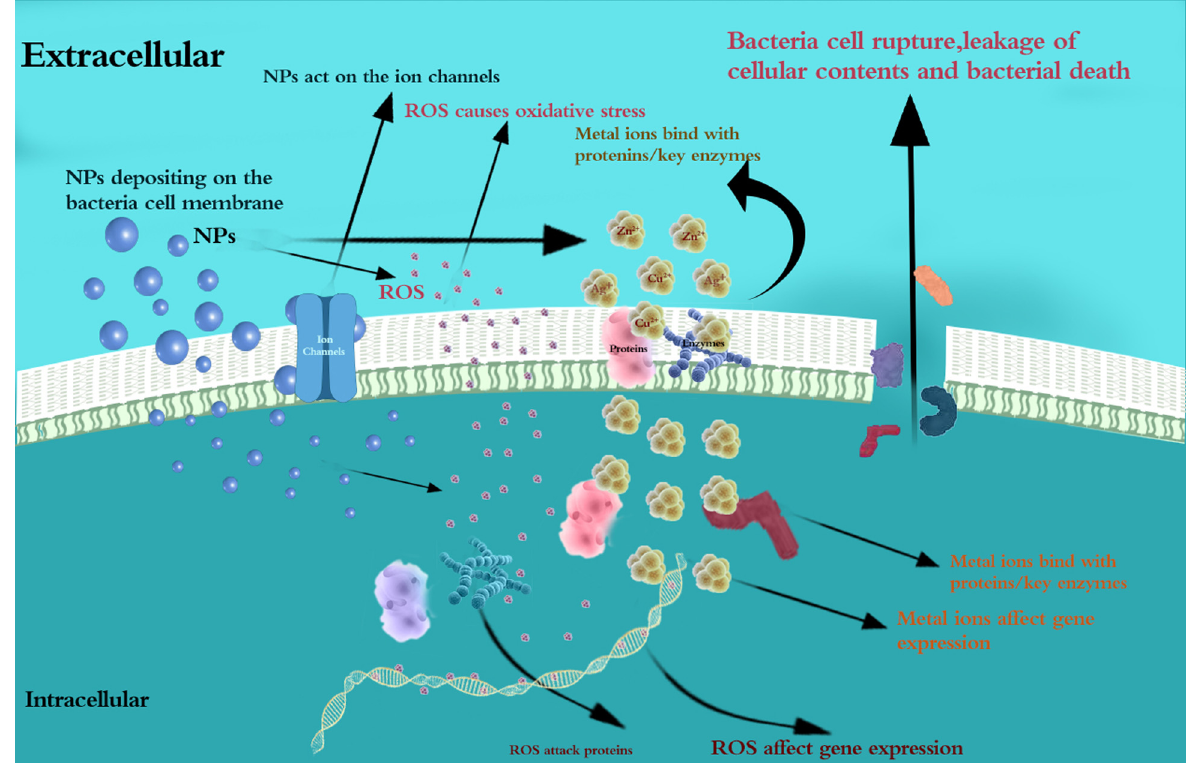
Figure 1: Antibacterial mechanism of NPs applied in orthodontic